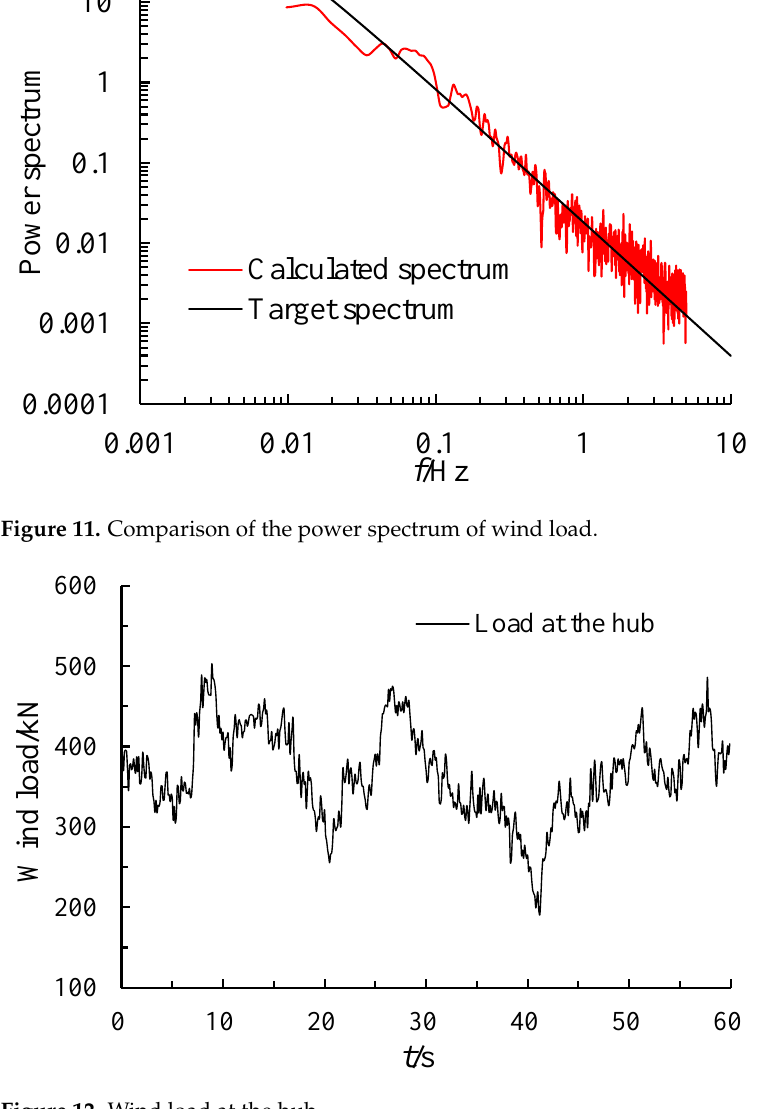
Figure 12. Wind load at the hub. In order to analyze the wind load effect on the dynamic response of the OWTs, three mean wind velocities at a height of 10 m, V m ( 10, t ) = 5 m/s, 7.5 m/s and 10 m/s, are used to calculate the mean wind velocity in this study. Figure 13 demonstrates the lateral displacement and rocking angle atop the GBF when experiencing the wind loads only. The results show that the peak displacement of the GBF increases significantly with the increase of the mean wind velocity V m ( 10, t ) , and there is a large increment of lateral displacement occurring at the beginning of the wind loading stage. This is mainly attributed to the fact that the wind load is an asymmetric load, which results in the accumulation of displace- ment in the horizontal direction. This finding is also similar to the results reported by Cheng et al. [36] in terms of the effect of environmental loads on the suction foundation. This phenomenon also can be found in the soil stress–strain hysteresis curves at 0.5 m from the soil surface given in Figure